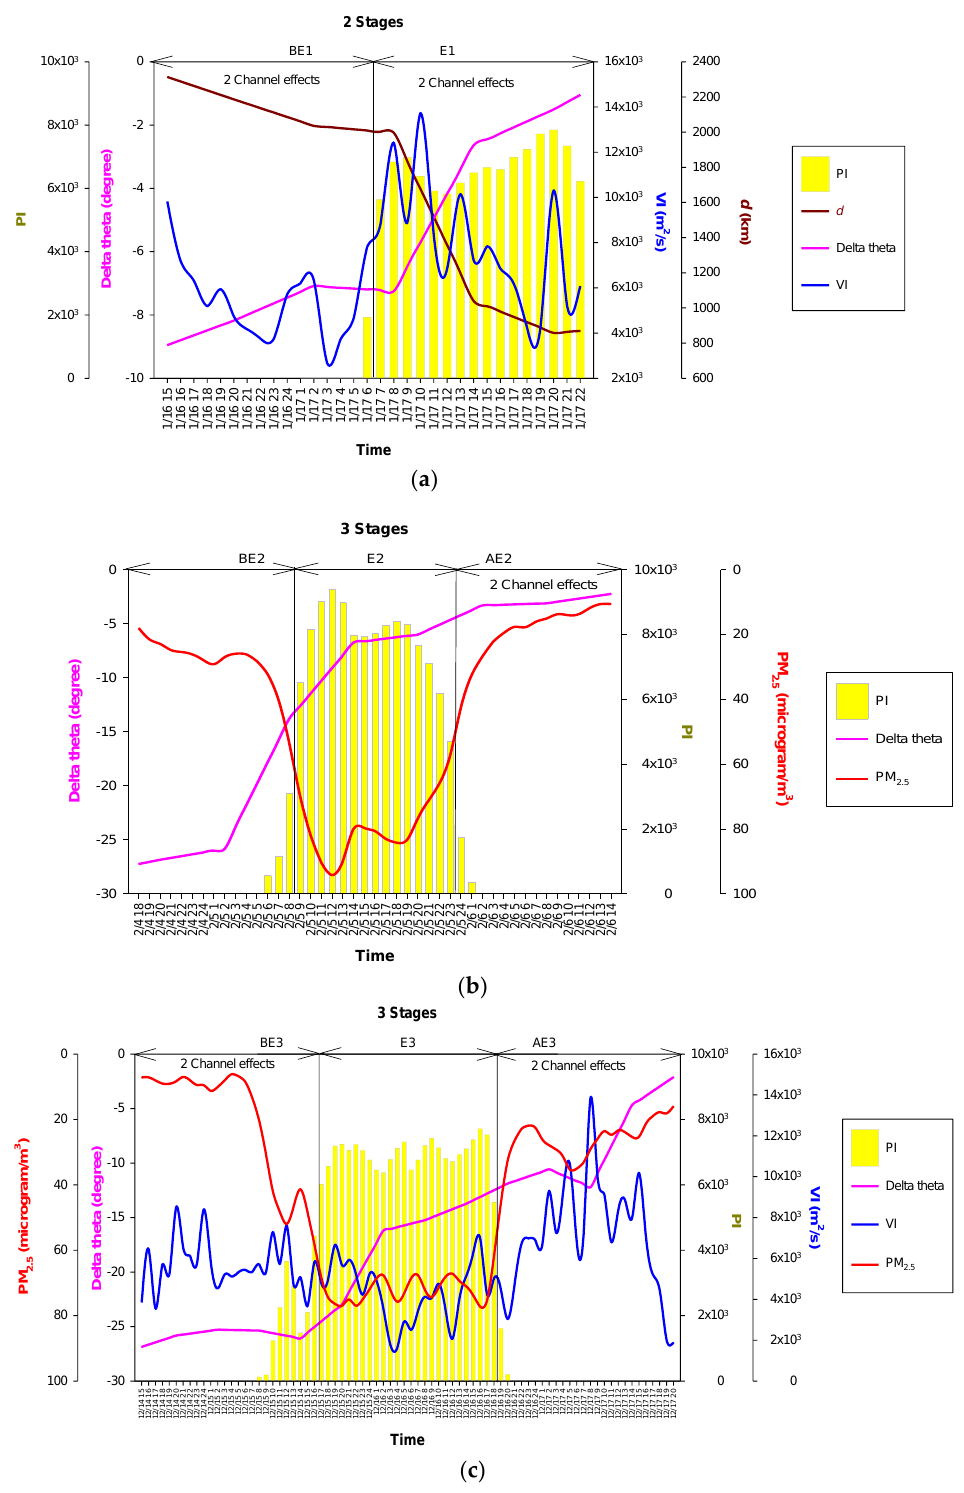
Figure 7. Time series of PM 2.5 concentration ( µ g · m − 3 ), pollution index (PI), ventilation index (VI, m 2 · s − 1 ), distance between the centre of the continental high-pressure system (CHPS) and Taipei ( d , km), and difference in longitude ( ∆ θ ) between the CHPS centre and Taipei during the three periods: ( a ) period 1; ( b ) period 2; ( c ) period 3. BE1: before event one stage; E1: during event one stage; BE2: before event two stage; E2: during event two stage; AE2: after event two stage; BE3: before event three stage; E3: during event three stage; AE3: after event three stage.